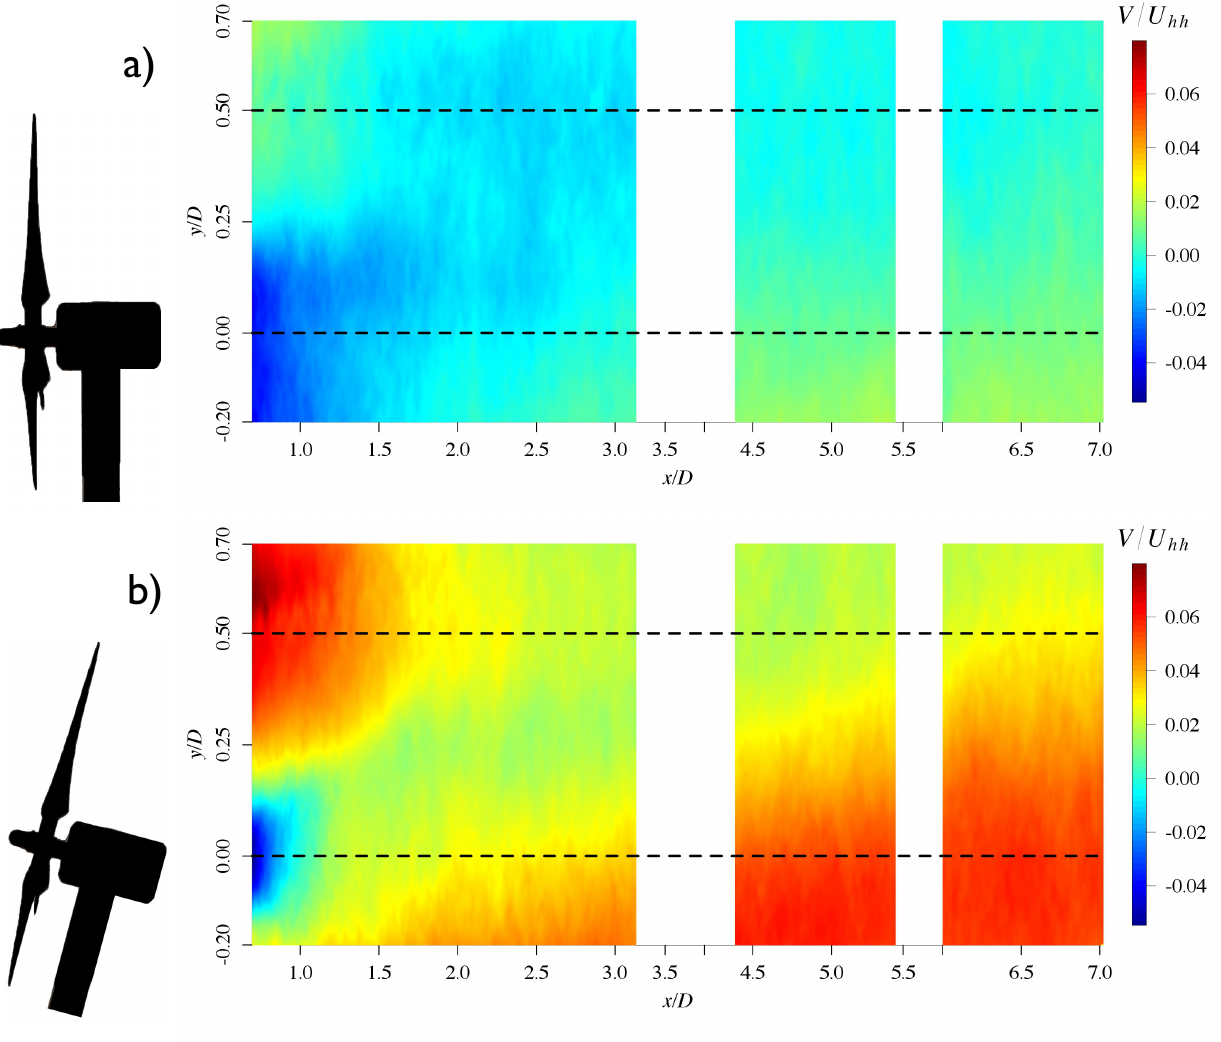
the region from 6.1 D to 7 D . Notably, a wall normal velocity of 0.04 U for the floating case represents hh 980% of V / U for the same location in the fixed case. hh Figure 6. Normalized wall normal velocity component V / U of the wake for the fixed and hh floating cases. In the fixed case, V/U is close to zero. In the floating case, V/U increases hh hh with increasing x/D . Hub height ( y/D = 0) and top blade tip ( y/D = 0.5) are indicated by dashed horizontal lines.